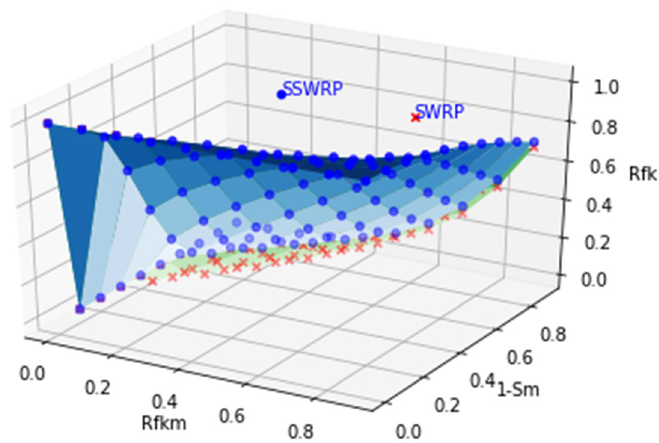
Figure 3. Variation of R fk for SSWRP and SWRP.